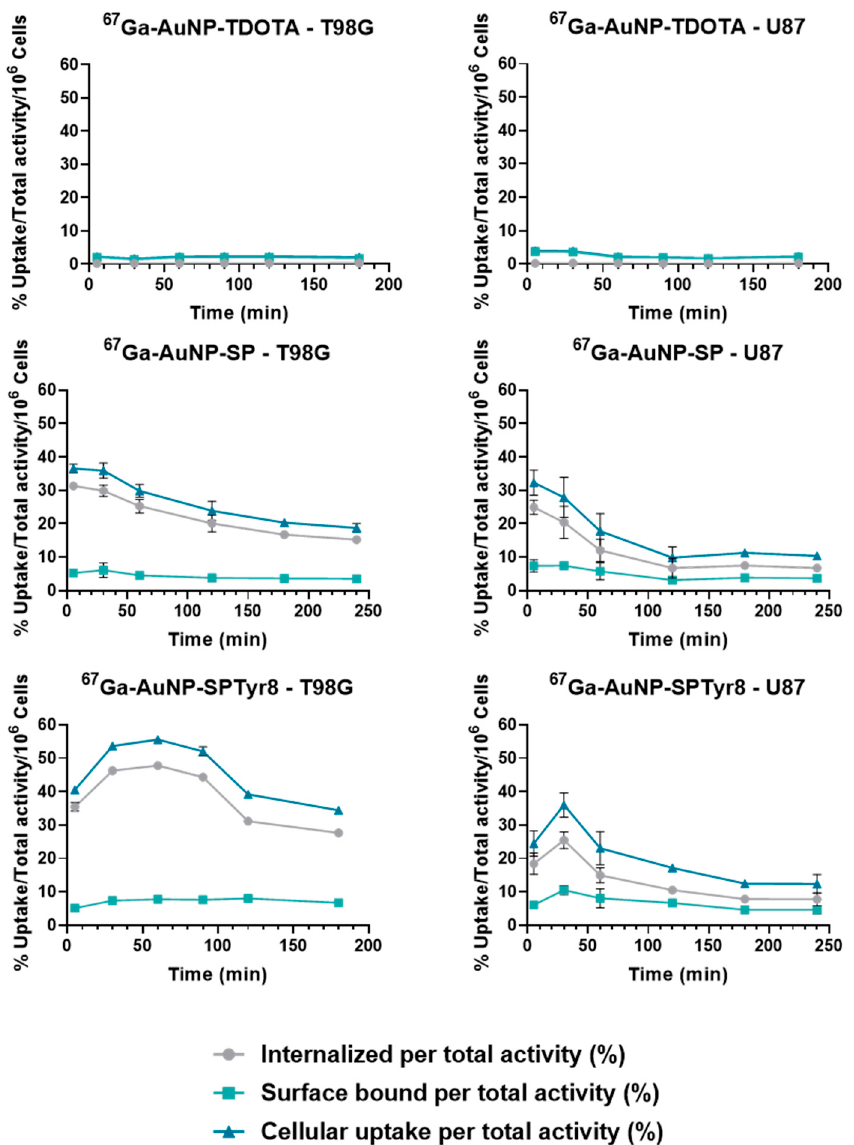
Figure 5. Cellular uptake and internalization of 67 Ga-AuNP-TDOTA, 67 Ga-AuNP-SP and 67 Ga- AuNP-SPTyr8 in T98G and U87 cells at 37 °C and different incubation times, determined by γ - counting measurements. Results are expressed as the percentage of the total (applied) radioactivity (mean ± SD) and normalized per million cells.